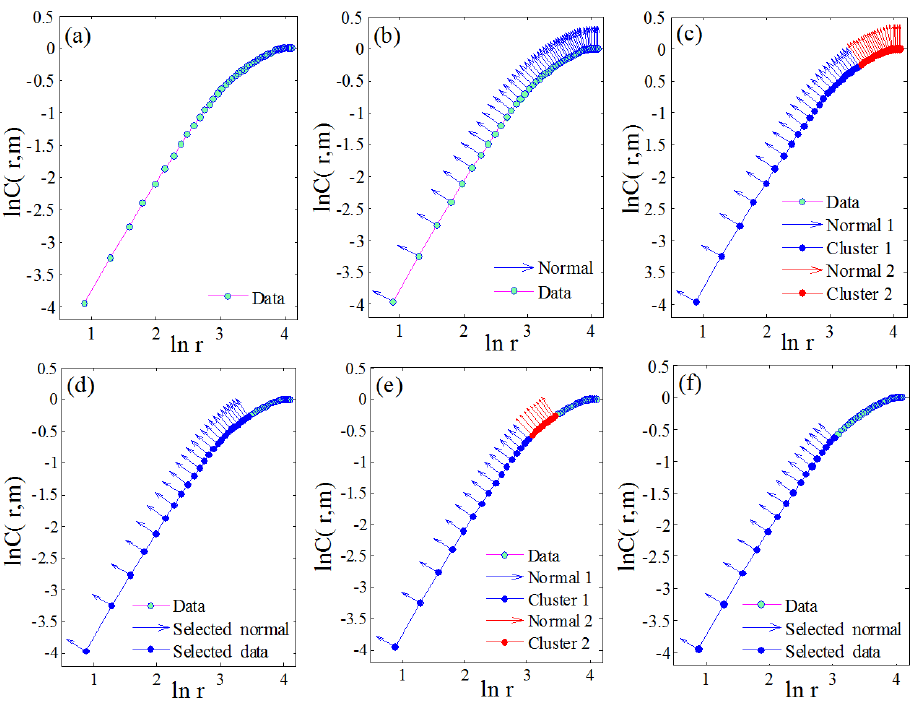
Figure 4. Illustration of using the normal-based K -means clustering technique for determining the scaling region. The curve shown here was randomly selected from Fig. 3.